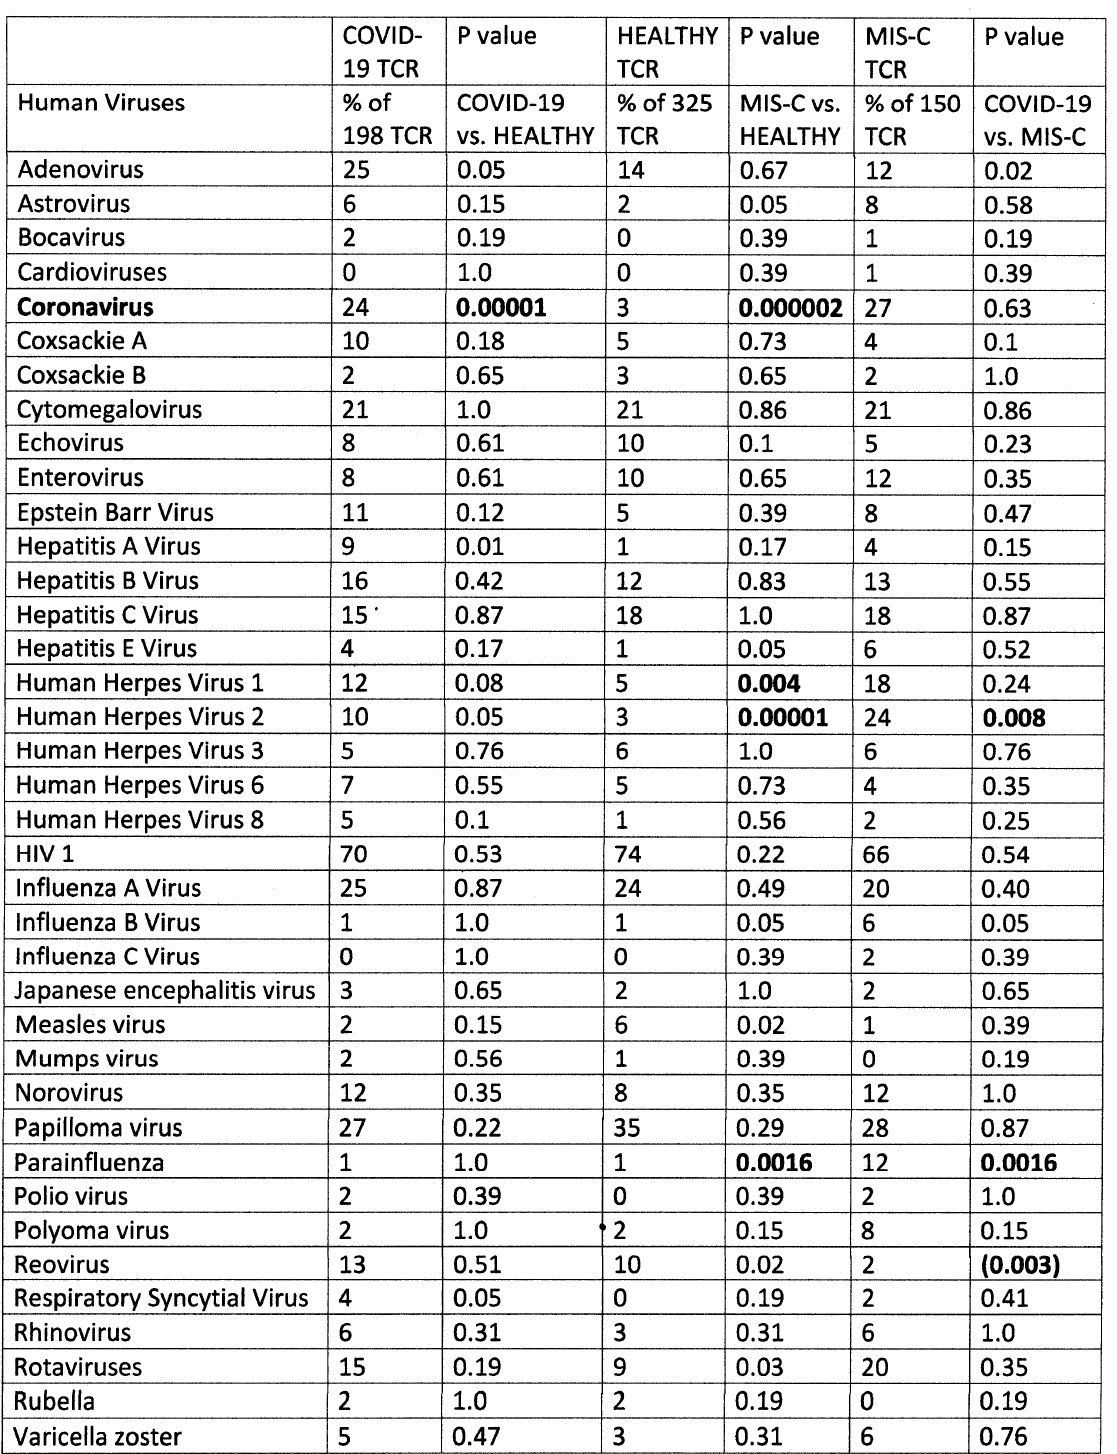
Figure 1. Summary of frequency (by percentage of TCRs tested) of TCR sequence similarities for hospitalized COVID-19 patients, healthy individuals, and multisystem inflammatory syndrome in children (MIS-C) patients to proteins from human viruses. The statistical significance of the differences between each pairing was determined by chi-squared analysis providing a p value. However, because each TCR was analyzed against every virus, a Bonferroni correction was required to interpret the resulting p values such that to reach a significance of p < 0.05 after the correction, the chi-squared value must be 0.002 or less. Values less than 0.002 or approaching it are bolded in the figure for ease of recognition.